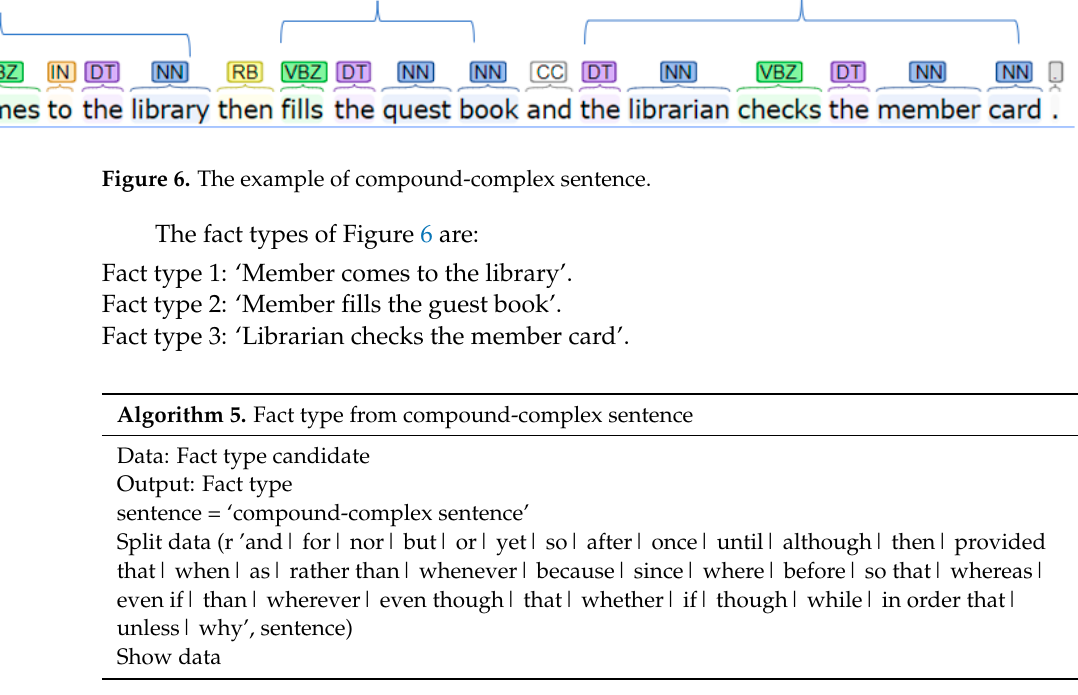
Algorithm 6. Extracting process name